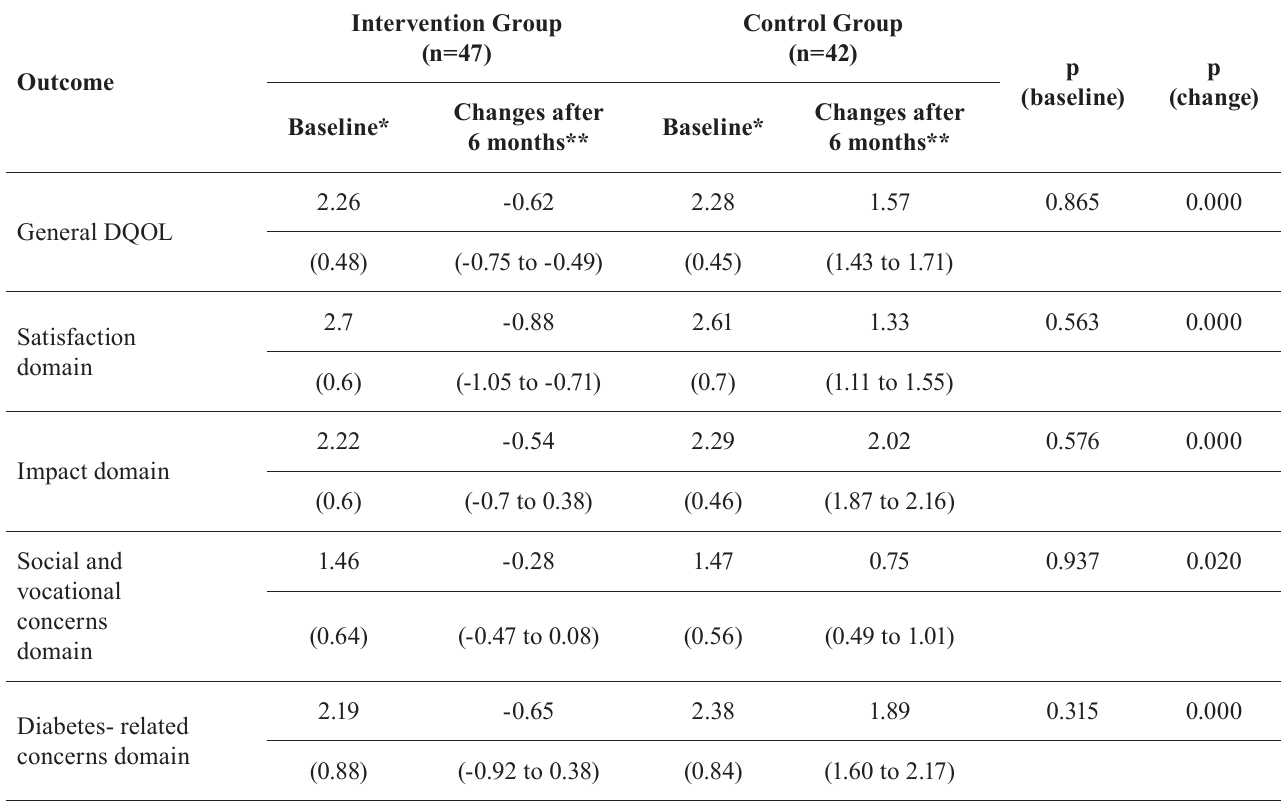
TABLE II - Charges observed in the quality of life indices of patients in the intervention and control groups after 6 months of study